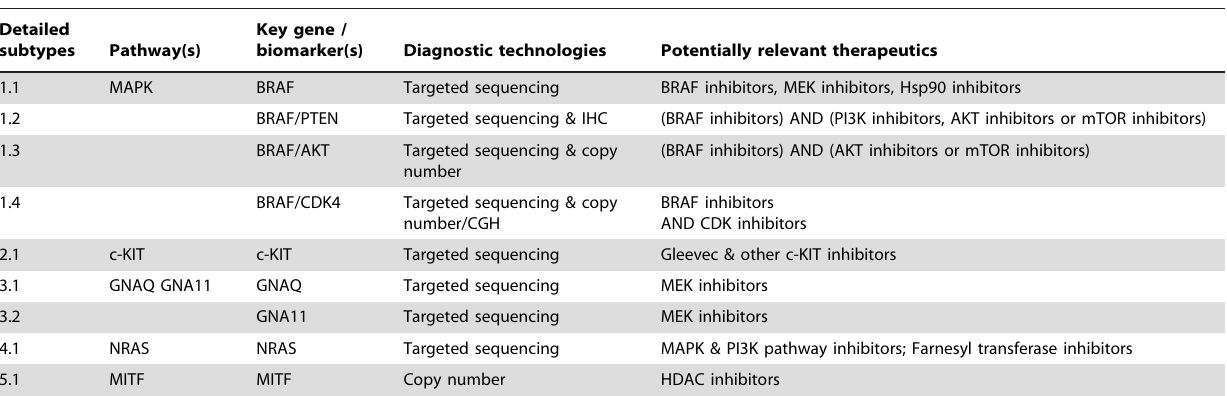
Table 1. Principal melanoma molecular subtypes.